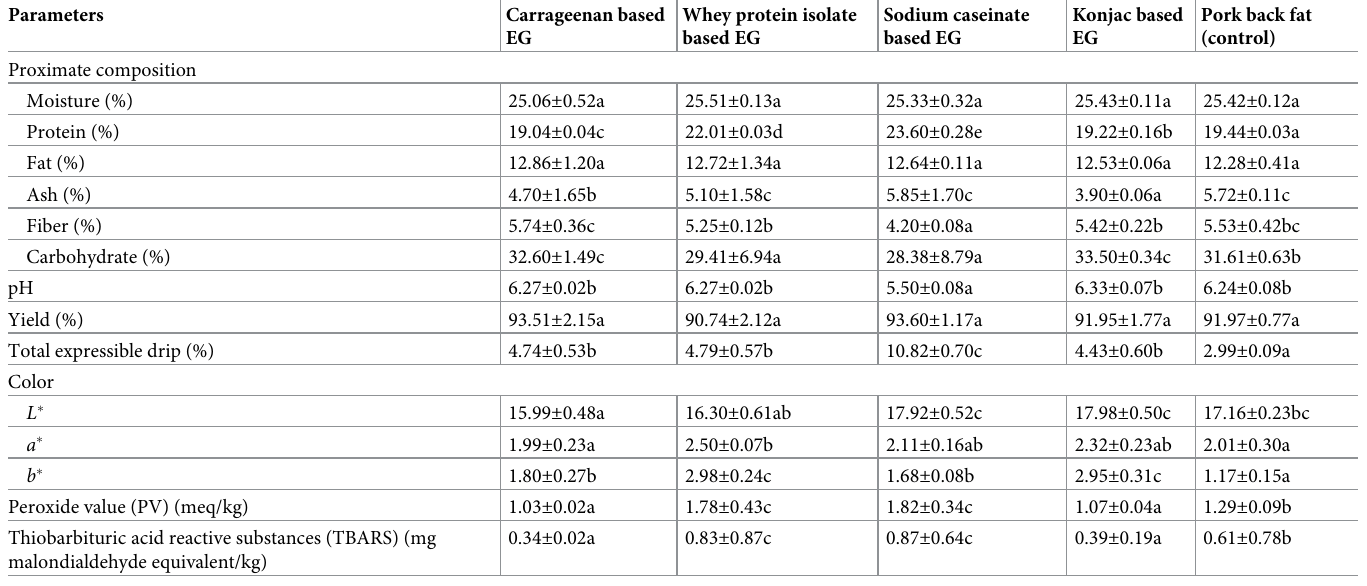
Table 1. Proximate composition and physicochemical characteristics of semi-dried Chinese style tilapia sausages formulated with and without different types of emulgel